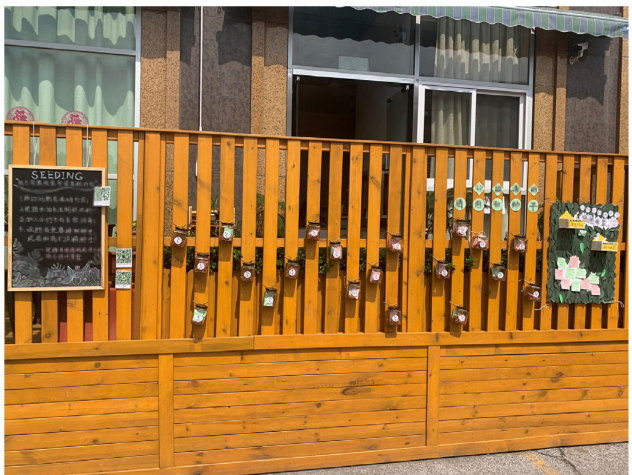
Figure 2. The seed relay station in front of Mr. Zhu’s Club. (The Chinese guidance of the Seeding activity in the photo is pixelated according to the publication